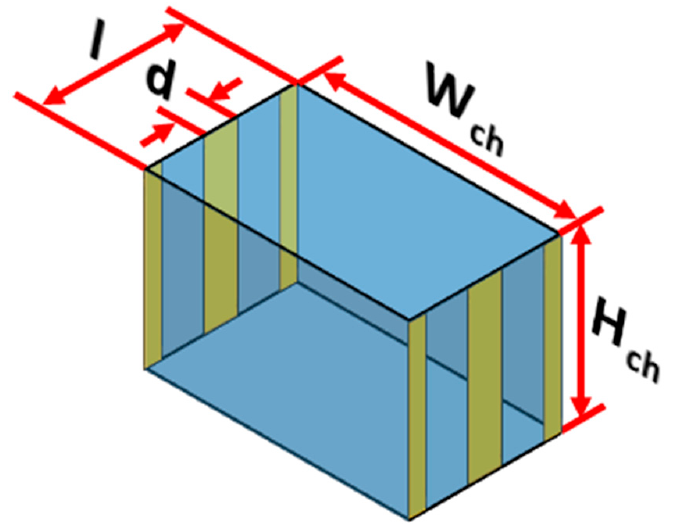
Figure 3. Schematic of the repeating unit of the proposed microfluidic device.